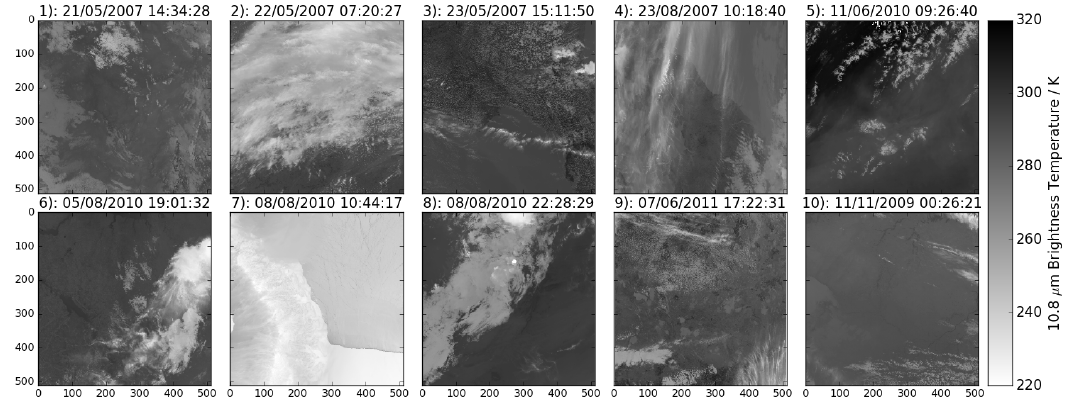
Figure 1. The 10.8- µ m brightness temperatures for the 10 submission scenes in the cloud clearing inter-comparison (Table 1) at native resolution ( ∼ 1 km). Individual plot headings give the scene number, date and orbit start